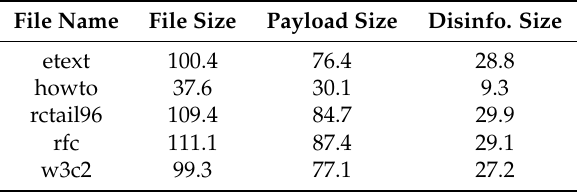
Table 5. The sizes of the payload and disambiguation information when non-UD coding is applied on the files that have non-uniform symbol